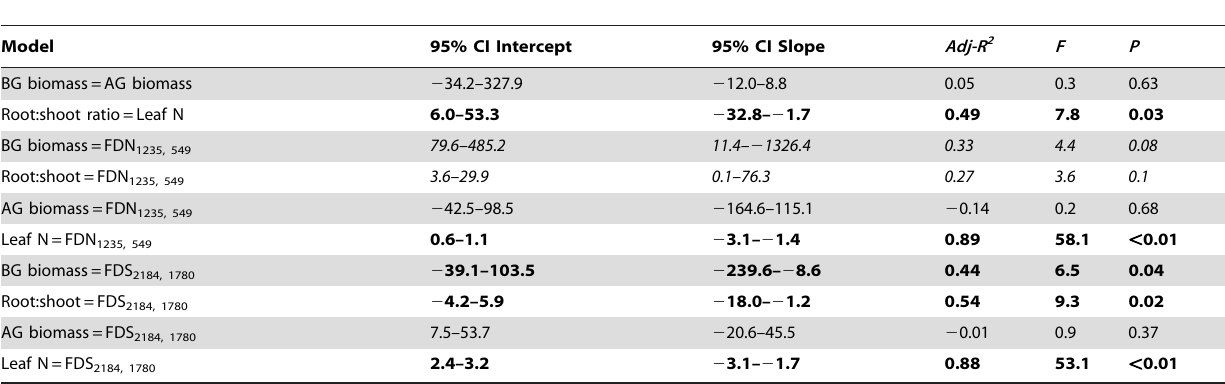
Table 3. Relationship of plant biophysical parameters with potential biophysical, chemical, and remote sensing-based nitrogen predictors (N= 8); 95% CI is the bootstrap bias corrected, accelerated 95% confidence interval based on 10,000 bootstrap